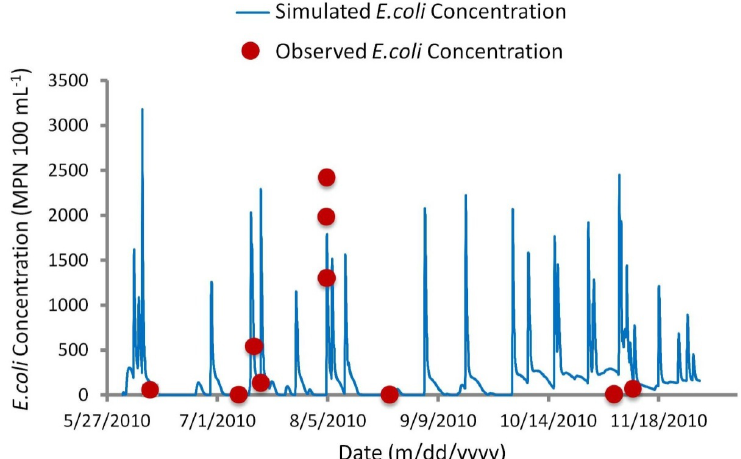
Figure 9. Simulated versus observed E. coli concentrations for calibrated advection dispersion